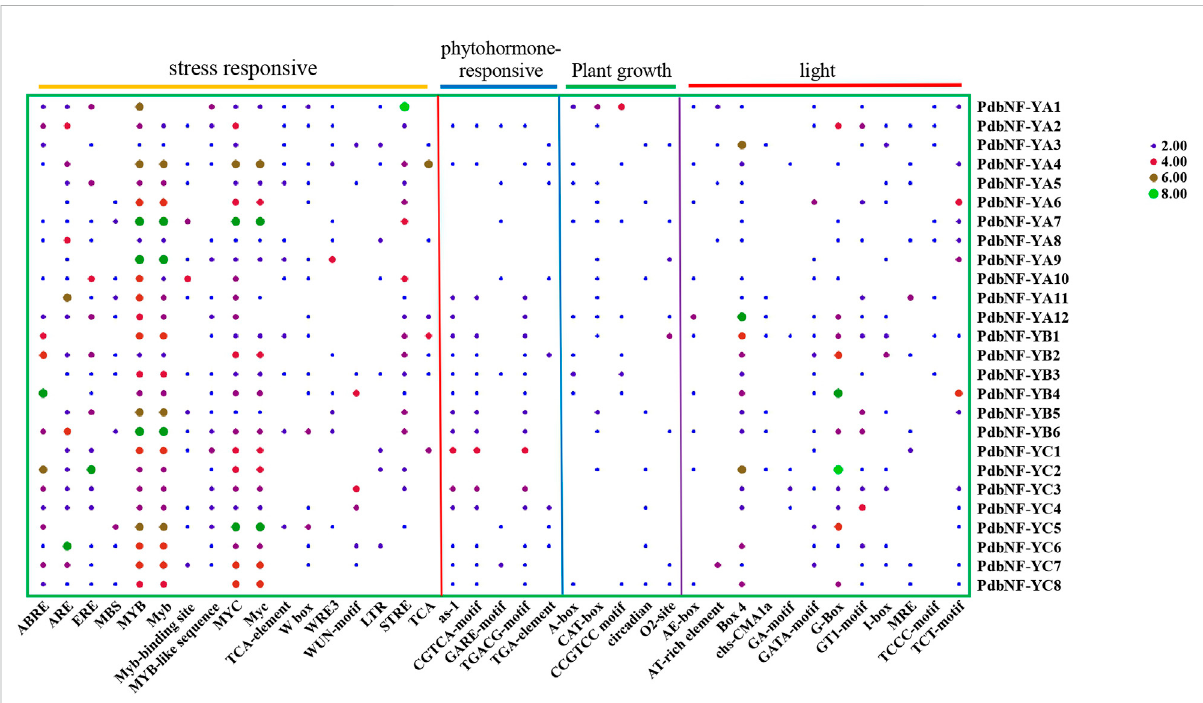
FIGURE 4 Heatmap of cis-elements in the promoter regions of the PdbNF-Y s. Colored bars indicate the numbers of